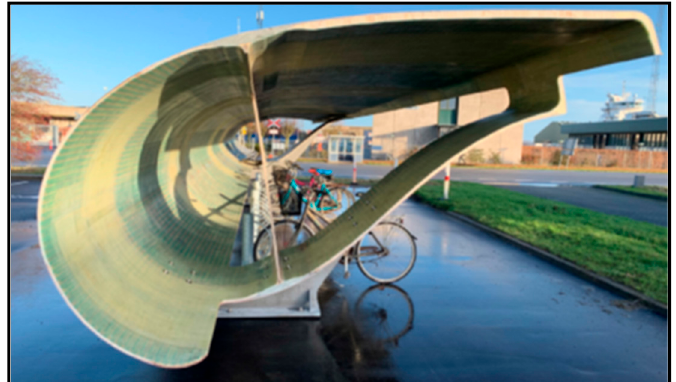
Figure 7. Examples for rotor blade repurposing: bike shed (source: Re-Wind and Port of Aalborg, Denmark, Wind Europe Report 2020), reproduced with permission of WindEurope [13].